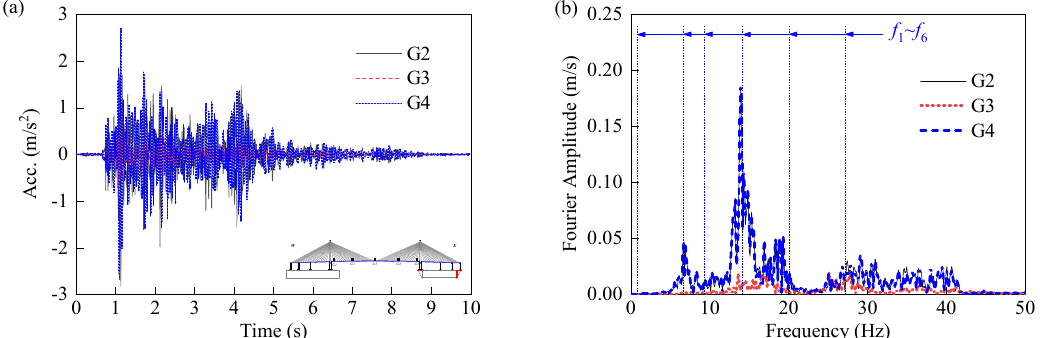
Figure 21. Girder vertical acceleration under ScEL ( a ) Time history and ( b ) FFT.